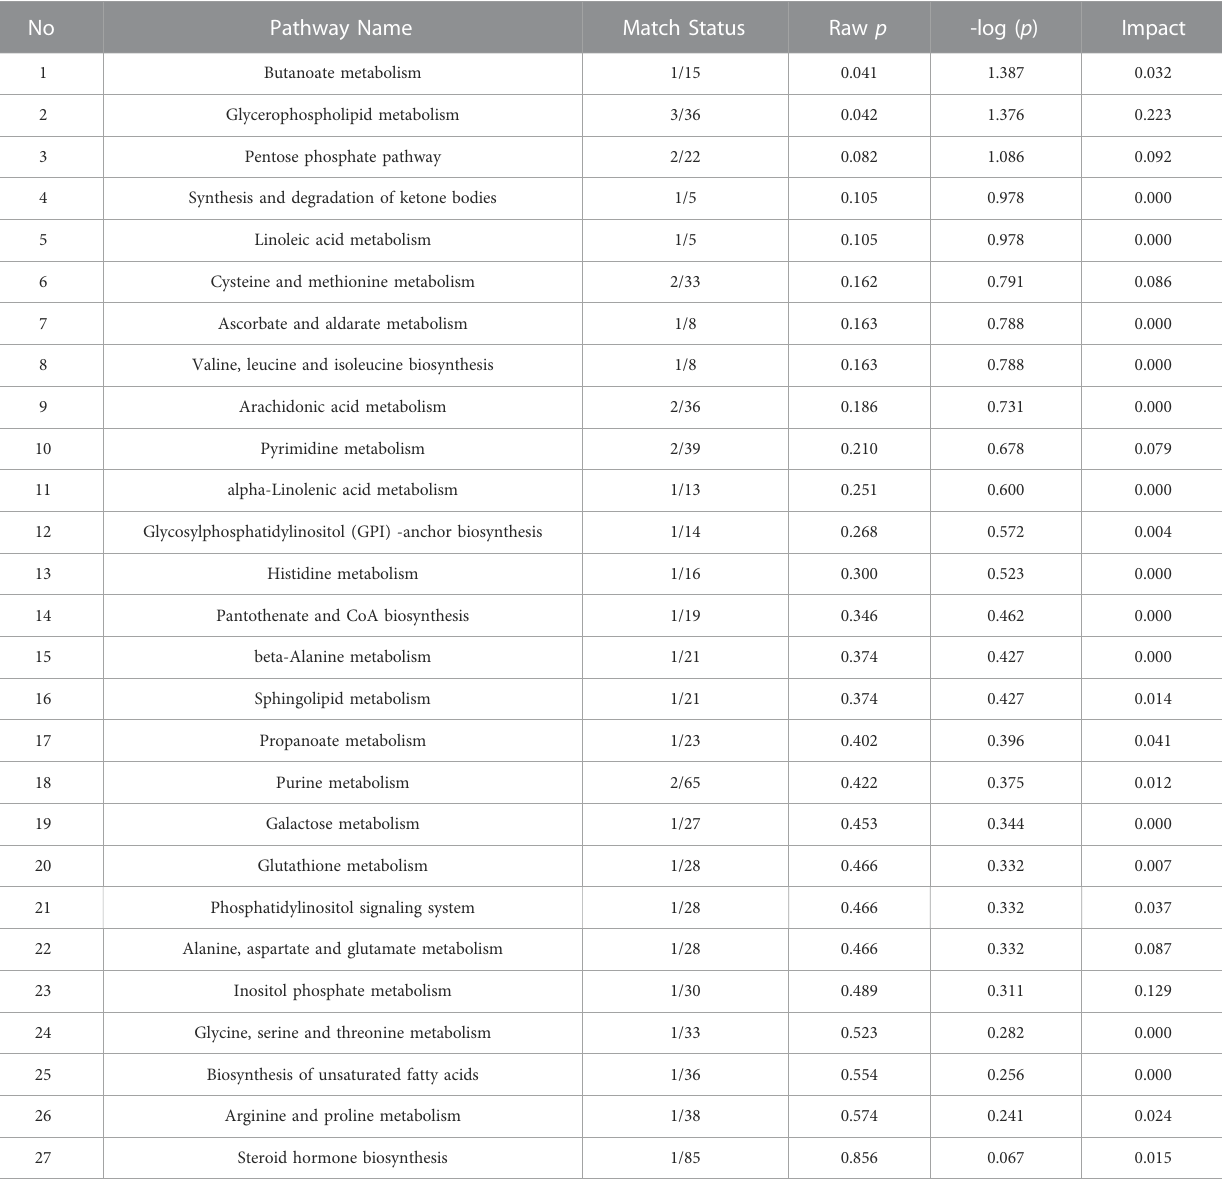
TABLE 2 Analysis of metabolic pathways in liver tissues based on potential biomarkers